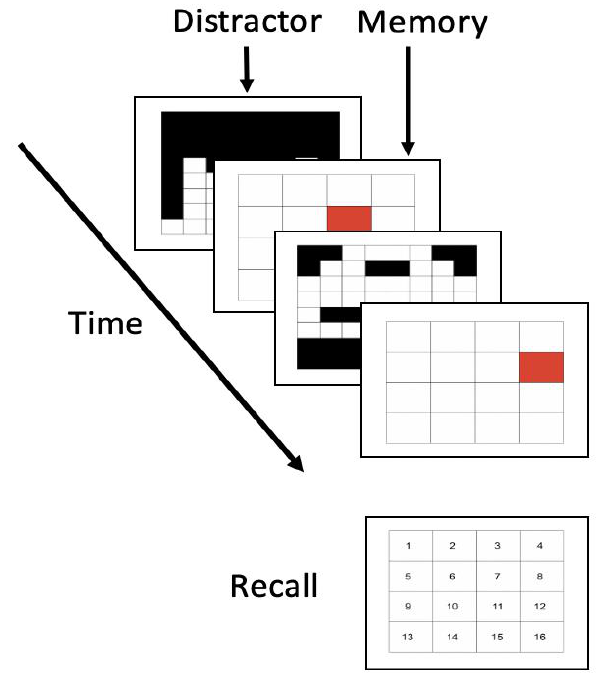
Figure 3. Symmetry Span Task.